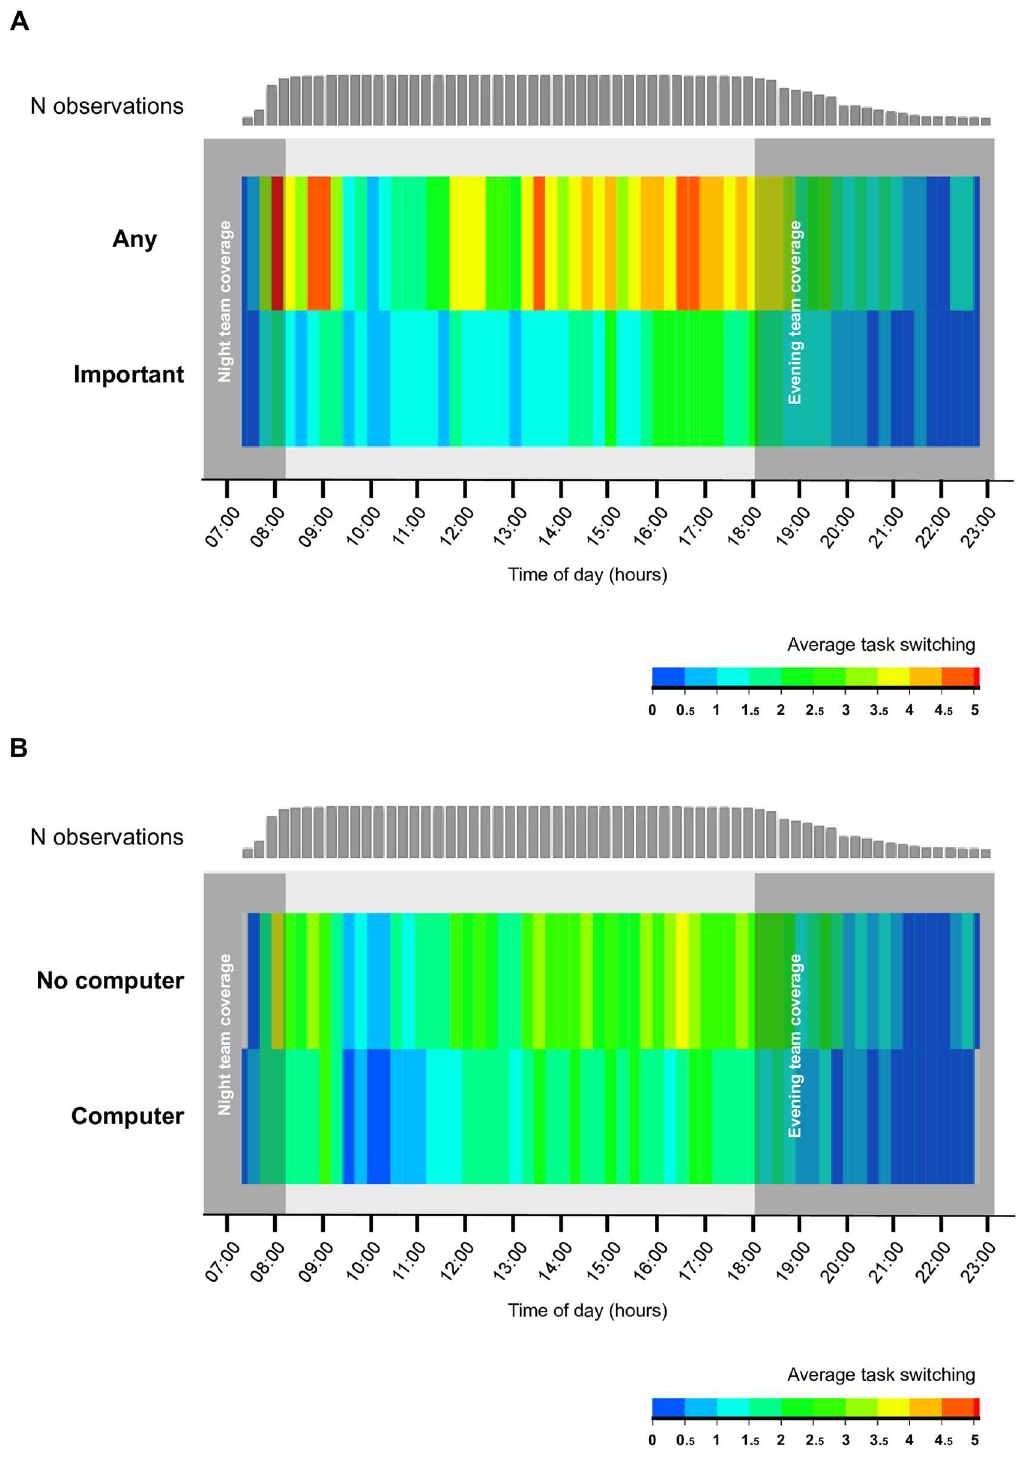
Fig 1. Averagenumber of task-switching during day shifts. Panel A: By task category. Panel B: By computer usage. Time was split in 15-min periods; the black bars in the top row indicatethe number of observations(range 1–49). ANY: switch from any task to another. IMPORTANT: switch from one medicallyimportant task (i.e. medical rounds, handoffs, writing in medicalrecords, meetingswith families and academicteachingreceived)to